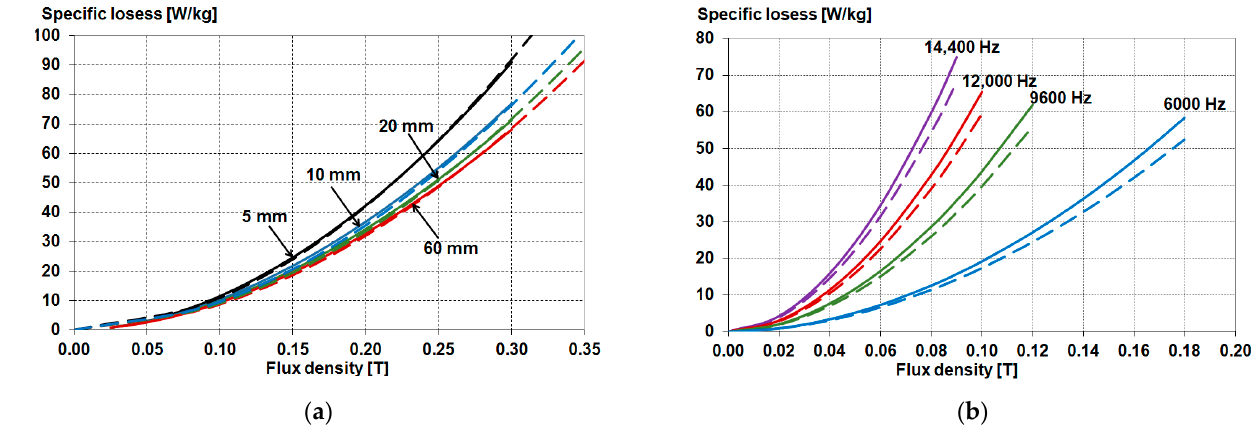
Figure 19. Measured and approximated specific losses characteristics of M 270-35A sheet for various widths of sheared sheet samples, at a frequency of 4000 Hz ( a ), (measured—solid line, estimated— dashed line), and approximated characteristics for sheared M 270-35A sheet samples with a width of 10 mm (solid line) and 60 mm (dashed line), at frequencies 4000 Hz < f ≤ 14,400 Hz ( b ).